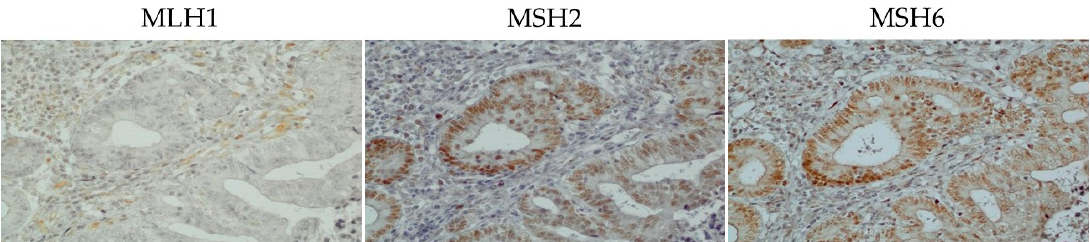
Figure 6. Immunohistochemistry for MMR proteins. MLH1 was absent (negative staining). MSH2 and MSH6 showed normal positive staining.